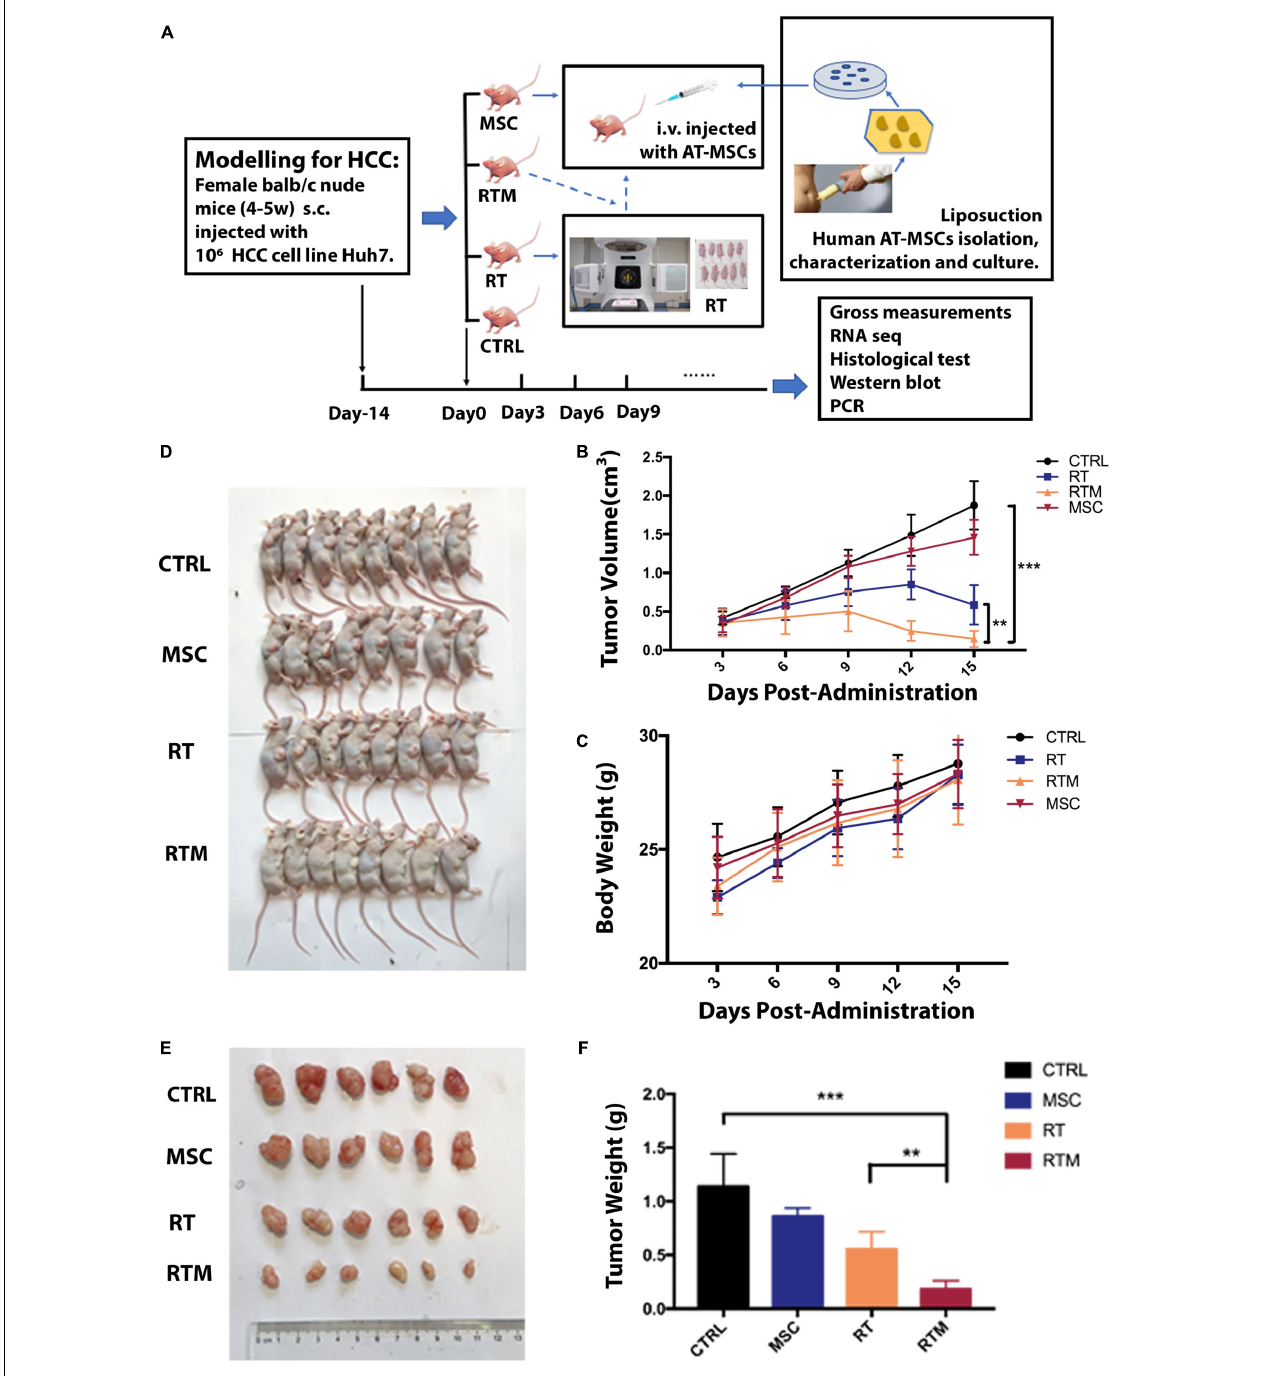
FIGURE 4 | Adipose tissue-derived mesenchymal stem cells (AT-MSCs) enhance the anti-HCC effects of RT efficiently in vivo . (A) Schematic illustration of animal study schedule. Flowchart showing the preparation and culture of AT-MSCs. Treatment was started when the tumor reached ∼ 100 mm 3 , designed as day 0. Orthotopic xenografts of HCC cells in female Balb/c nude mice were randomly divided into four groups: (1) CTRL group: tumors were injected with saline; (2) RT group: tumors were treated with radiation; (3) MSC group: tumors were treated with administrated 1 × 10 6 AT-MSCs; and (4) RTM group: tumors were injected with AT-MSCs via the tail vein on day 0 immediately after radiation exposure. (B) Subcutaneous tumor volumes (mm 3 ) in all groups was plotted. Data represent the mean tumor volume in each group measured on the indicated day ( n = 10 mice per group. ∗∗ P < 0.01, ∗∗∗ P < 0.001). (C) Body weight of mice after treatment at the indicated time points ( n = 10 mice per group). (D) Representative images of mice with induced tumors at the endpoint. (E) Tumors from each group were excised on the indicated day. (F) The net tumor weight of mice in each treatment group. Tumors were harvested, and the weights were measured before lysis at the endpoint ( n = 8 tumors per group. ∗∗ P < 0.0, ∗∗∗ P < 0.001).